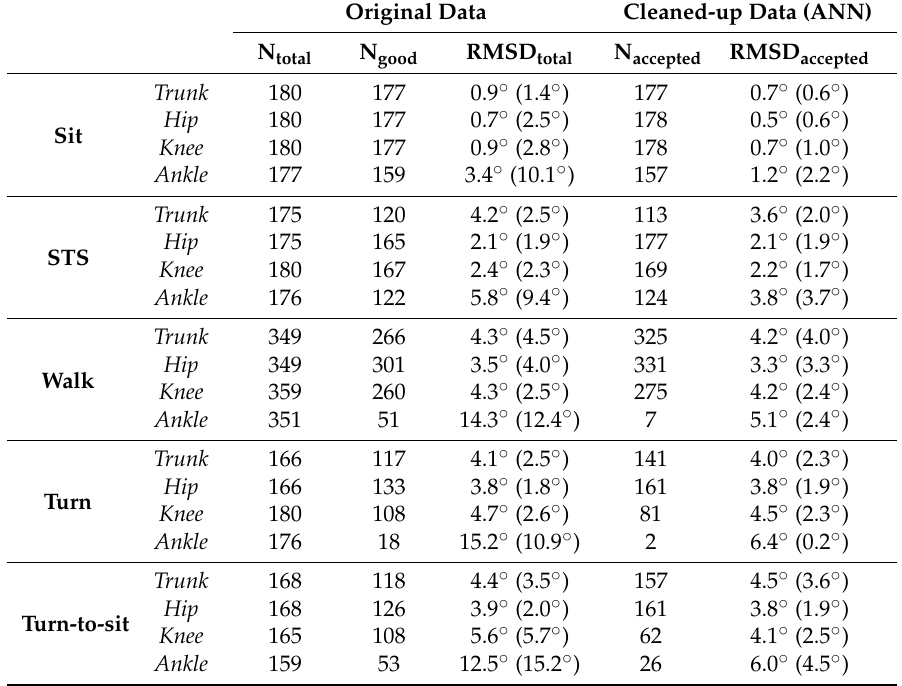
Table 2. Impact of autonomous quality control of orientation data sequences per task and